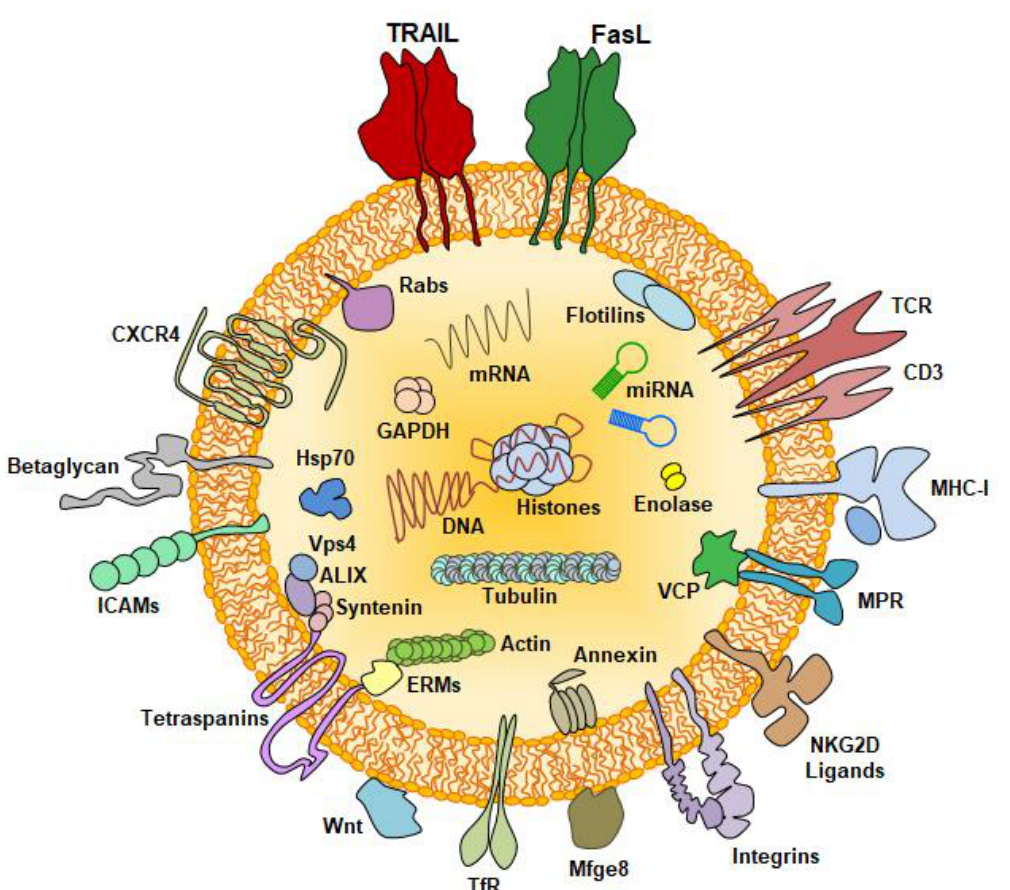
Figure 1. Schematic representation of a T cell derived exosome, showing the location of several of the most important functional proteins expressed, together with miRNA and DNA.